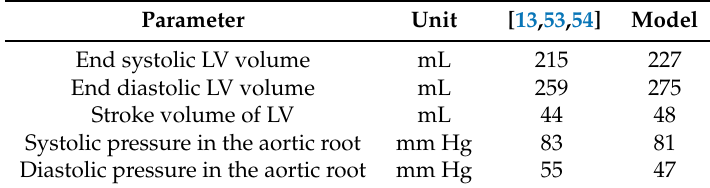
Table 7. Comparison of LV DCM simulations without LVAD with the data from the literature